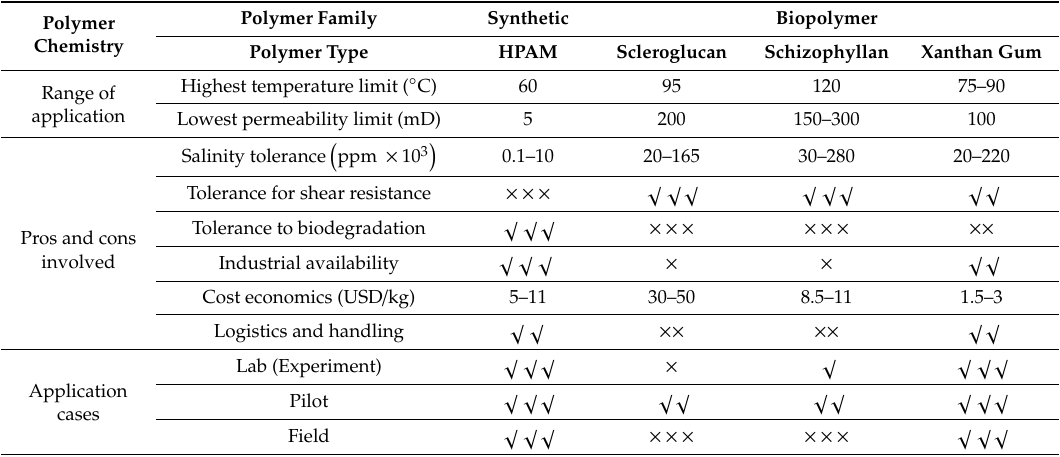
Figure 21. Graphical representation of the averaged polymers’ ( A ) temperature; ( B ) permeability; ( C ) salinity tolerance; ( D ) cost. Table 8. Ranking of polymers based on merit and demerits. Some of the data presented were obtained from the study by [22] with additional